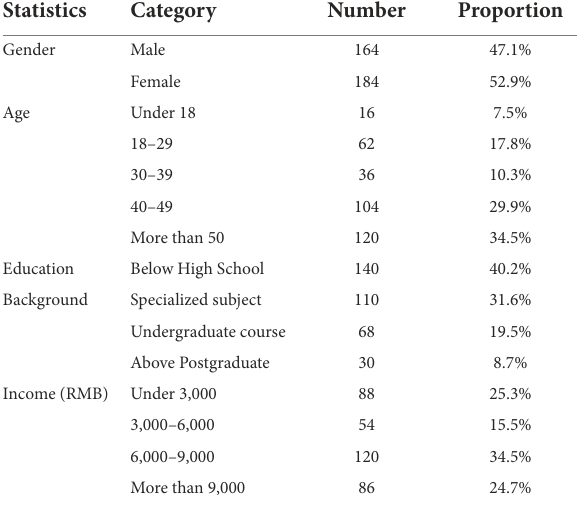
TABLE 1 Sample basic characteristic variable